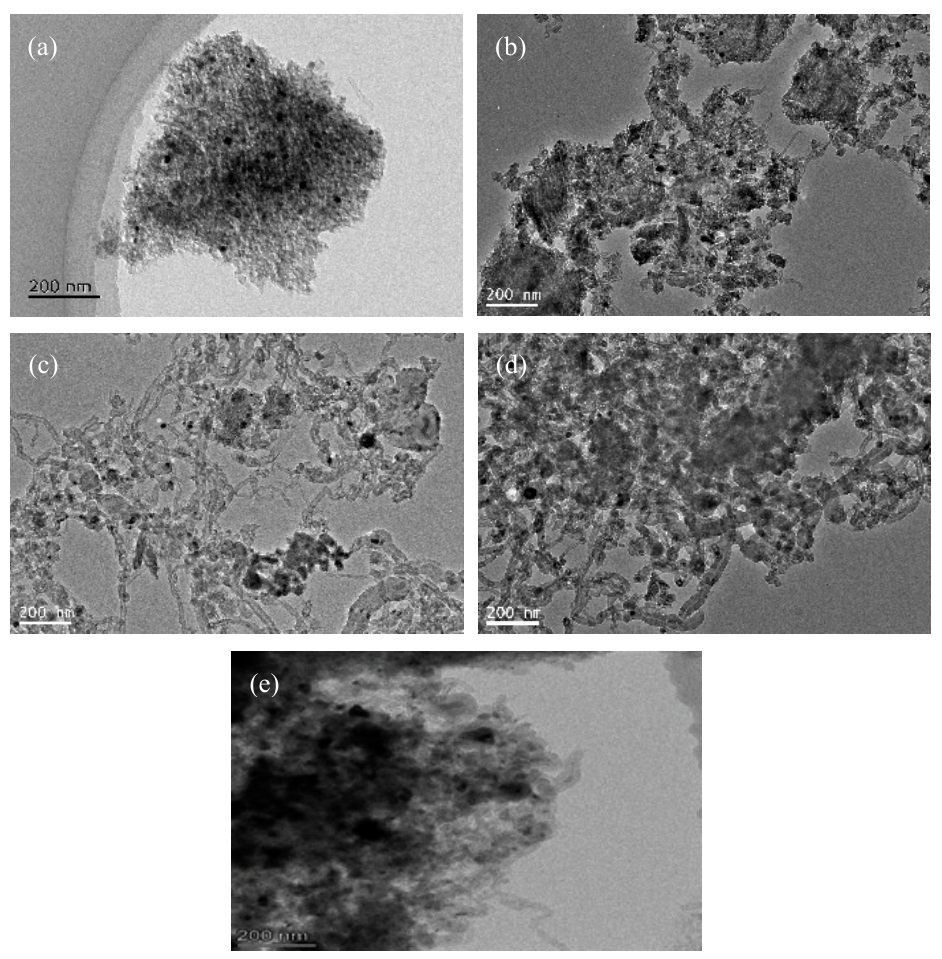
Figure 10. TEM images of spent catalysts. 4% Ni/M100-MA ( a ), 6% Ni/M100-MA ( b ), 8% Ni/M100-MA ( c ), 10% Ni/M100-MA ( d ), and 12% Ni/M100-MA ( e ).